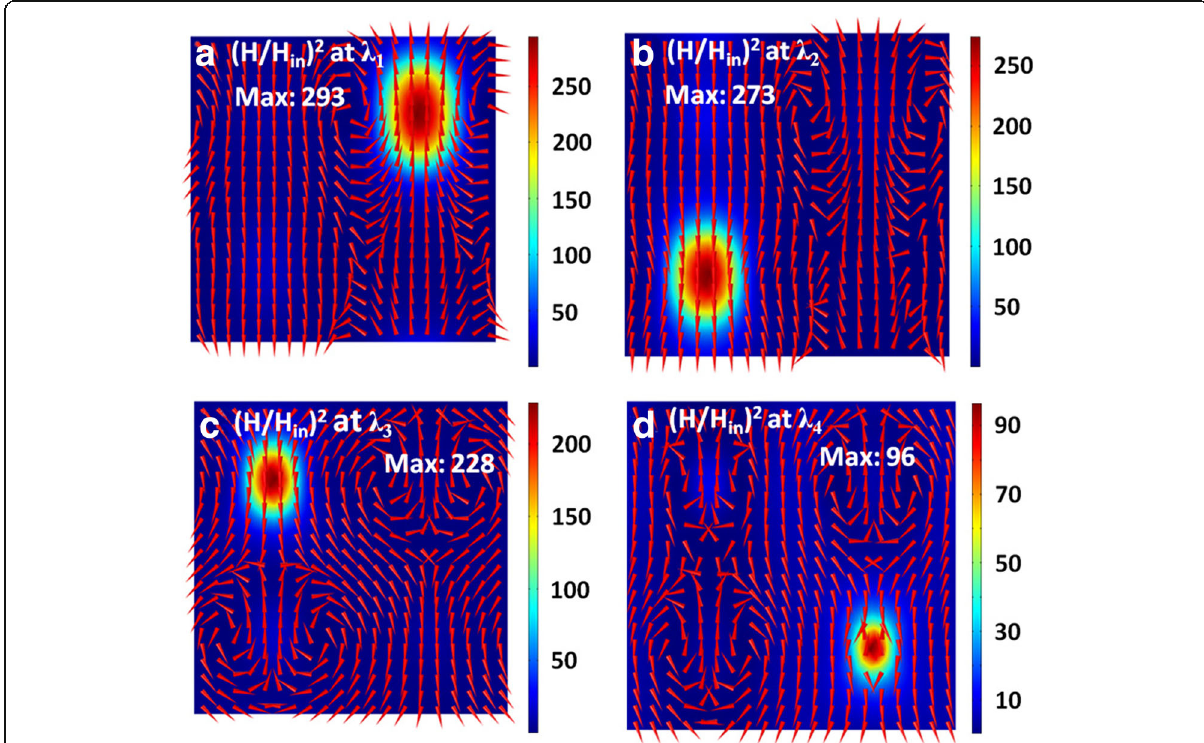
Fig. 4 The same as in Fig. 3, but for normalized magnetic field intensity ( H / H in ) 2